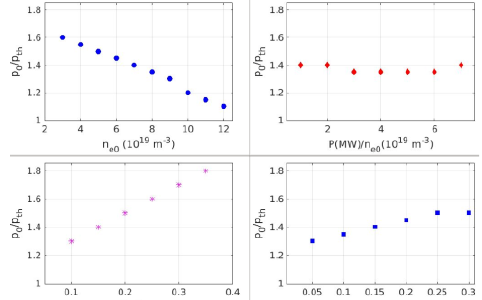
Fig. 13. Perturbation location in momentum that fits the full database for selected values of various quantities. Central density (top left), ratio of heating power and central density (top right), Alfvén velocity normalised to electron thermal velocity (bottom left) and fast ion beta (bottom